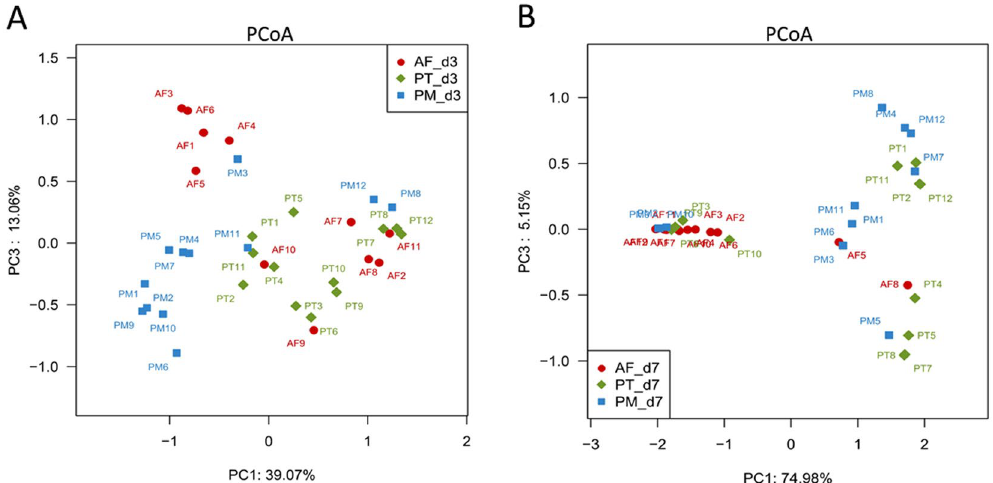
Figure 3. Principal coordinate analysis (PCoA) of microbial communities among PT and PM treatment groups and AF control group. ( A ) Distribution of all samples on d3; ( B ) Distribution of all samples on d7. Samples that are positioned close to each other are similar to each other in microbial compositions whereas samples that are positioned distantly from each other are distinct to each other in microbial compositions. AF, antibiotic free group; PT, piperacillin-tazobactam group; PM, combination of penicillin and moxalactam